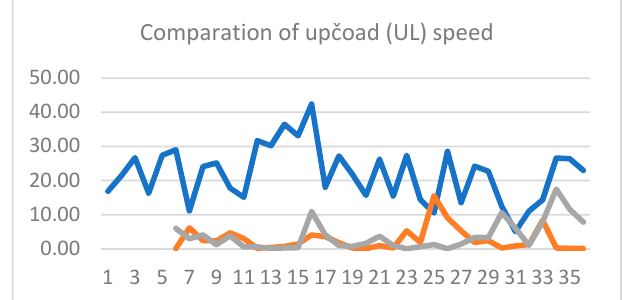
Figure A6. Comparison of upload speeds (MDMG).